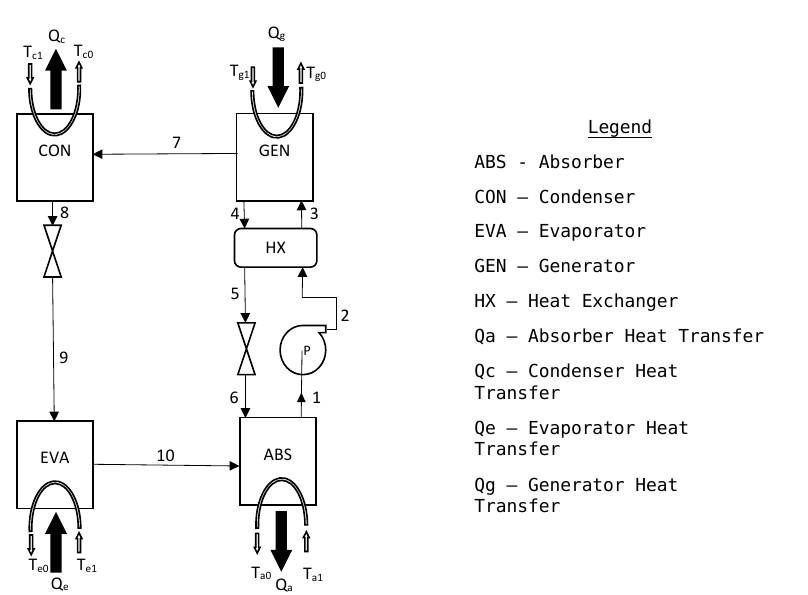
Figure 2. Schematic of the single-stage aqua-ammonia vapour absorption refrigeration